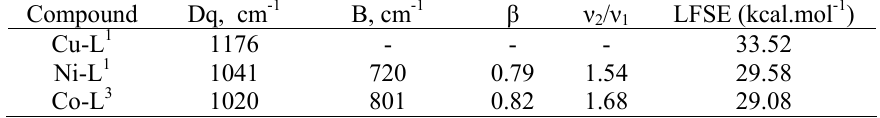
Table 4. Ligand field parameters of some complexes